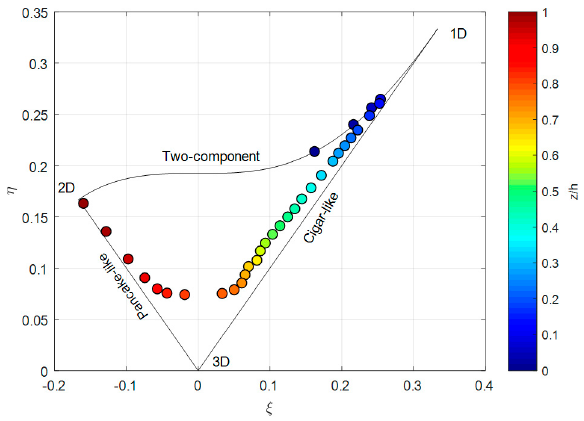
Figure 11. Turbulence triangle for the smooth bed case ( Re h = 13,680) (from [25]).